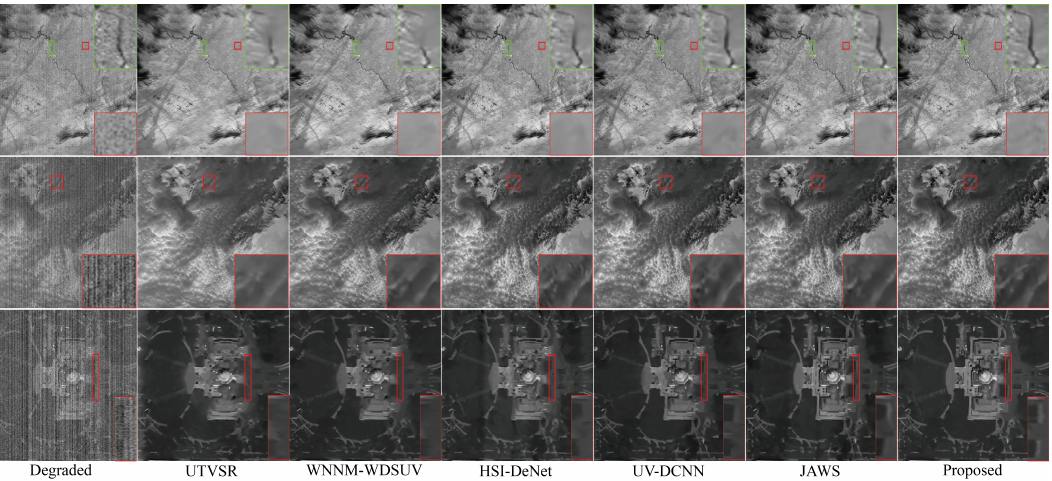
Figure 11. Visual comparisons of the estimated results on the synthetic SAM1 , SWDC , and SWDC images. For SAM1 : σ = 15, P = 0.4, and I = 10. For STM2 : σ = 20, P = 0.4, and I = 30. For SWDC : σ = 25, P = 0.6, and I = 30. The stripes on SAM1 and SWDC are nonperiodical while the stripe on STM2 is periodical.